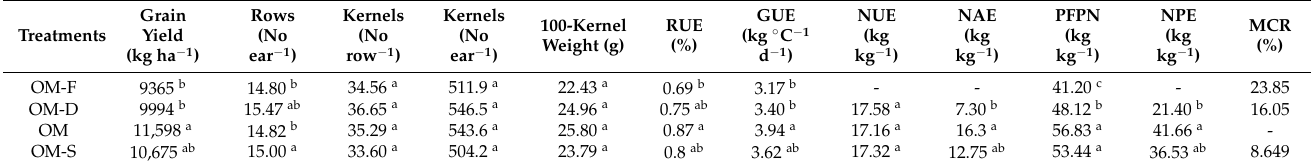
Table 3. Effect of different cultivation measures on grain yield and resource utilization of